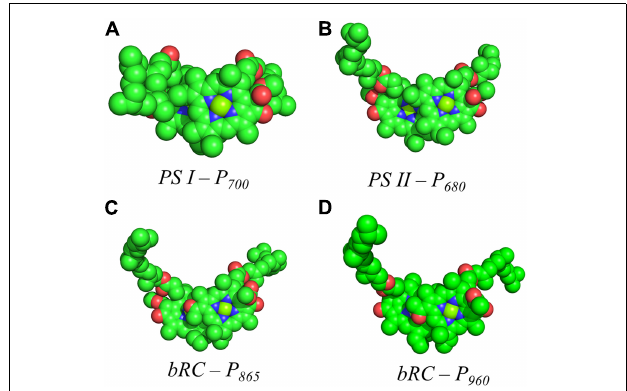
FIGURE 6 | Space filling models of (A) P 700 from PS I, (B) P 680 from PS II, (C) P 865 from the bRC of Rba. Sphaeroides and (D) P 960 from the bRC of Rps. Viridis